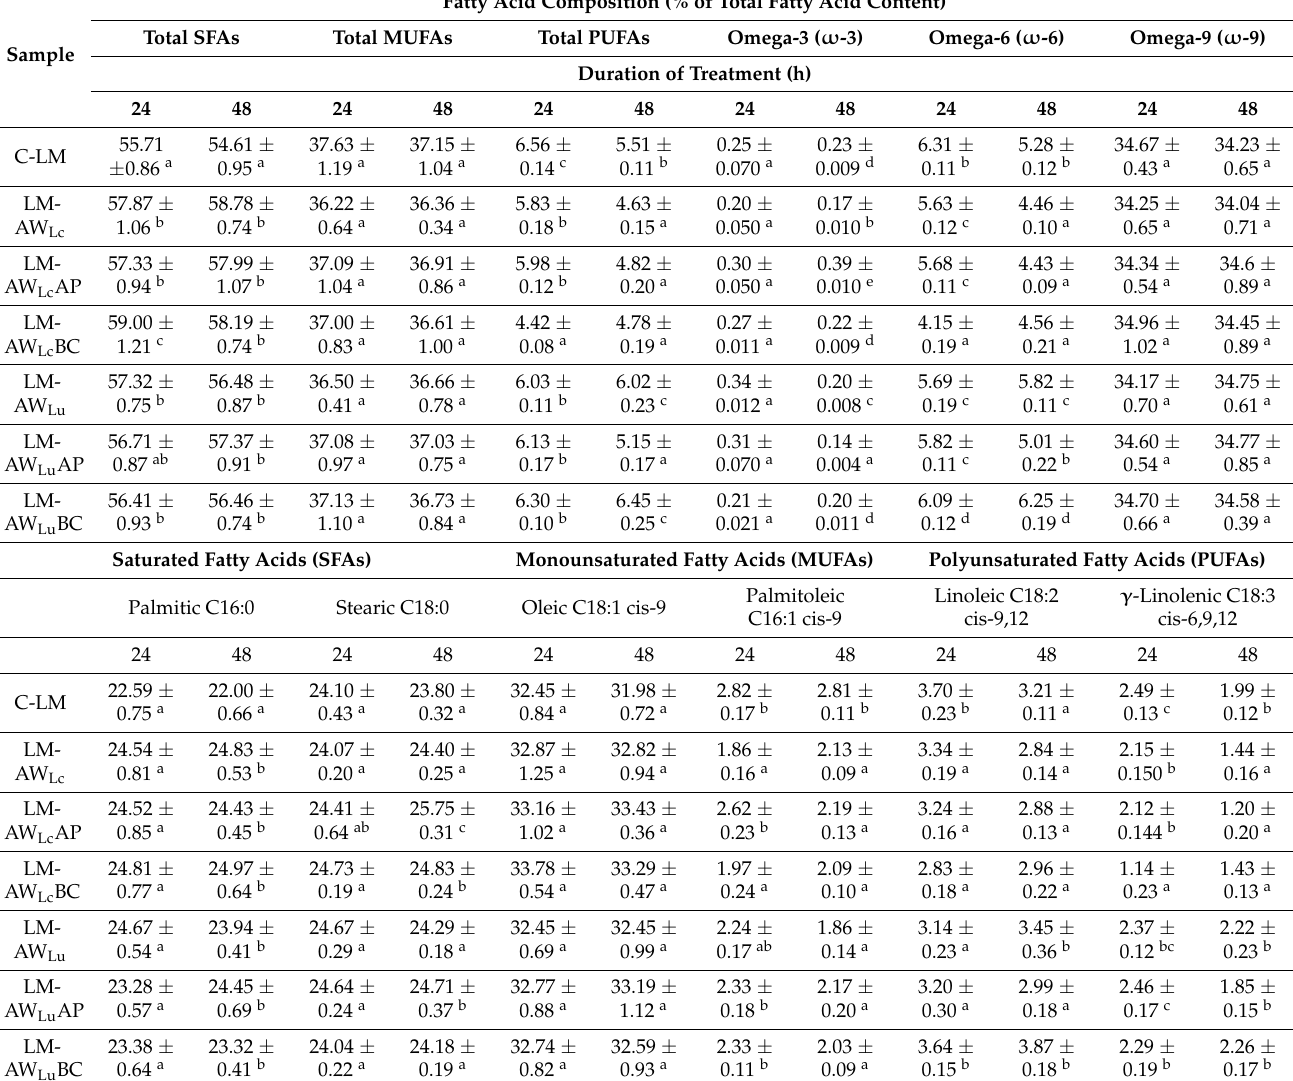
Table 9. The fatty acid compositions (as a percentage of the total fatty acid content) and the major fatty acids of the LM